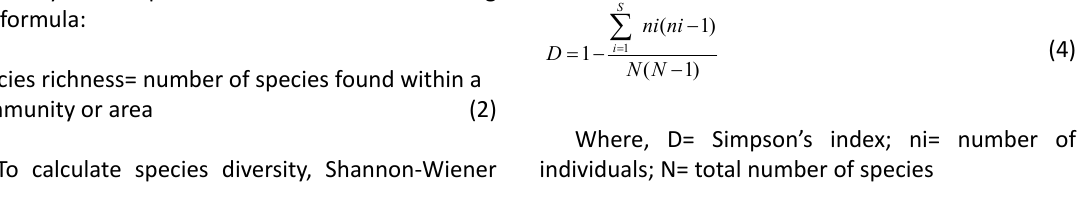
Where, H’= diversity index; ni= number of Table 1: List of all native and alien species surveyed in Site 1 and Site 2 of Mt. Manunggal, Cebu Island, Philippines Taxa family Plant species Site 1 Site 2 Total Abundance (%) species.